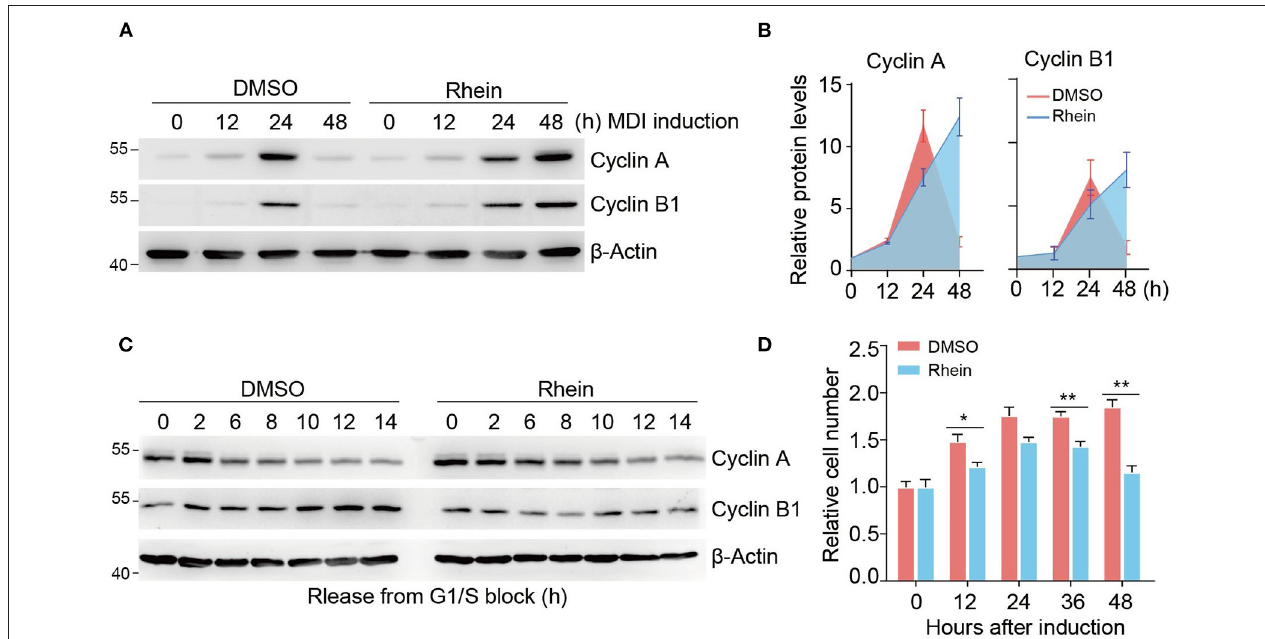
FIGURE 3 | Rhein impairs the MCE progression during differentiation. (A) Immunoblotting of cell-cycle markers during MCE. Cells cultured in the MDI medium with or without rhein were collected at indicated time points for analysis. (B) Quantification of protein levels shown in (B) . Error bars, mean ± SEM; n = 3 biological replicates. (C) Immunoblotting of cell-cycle markers in cells released from G1/S boundary. Cells were arrested by using double thymidine block, released into fresh medium, and harvested at the indicated time points. (D) The effect of rhein on cell proliferation during MCE. Growth-arrested preadipocytes were induced by MDI medium and cell number was determined at indicated time points. Error bars, mean ± SEM; n = 6 biological replicates; * p < 0.05, ** p <